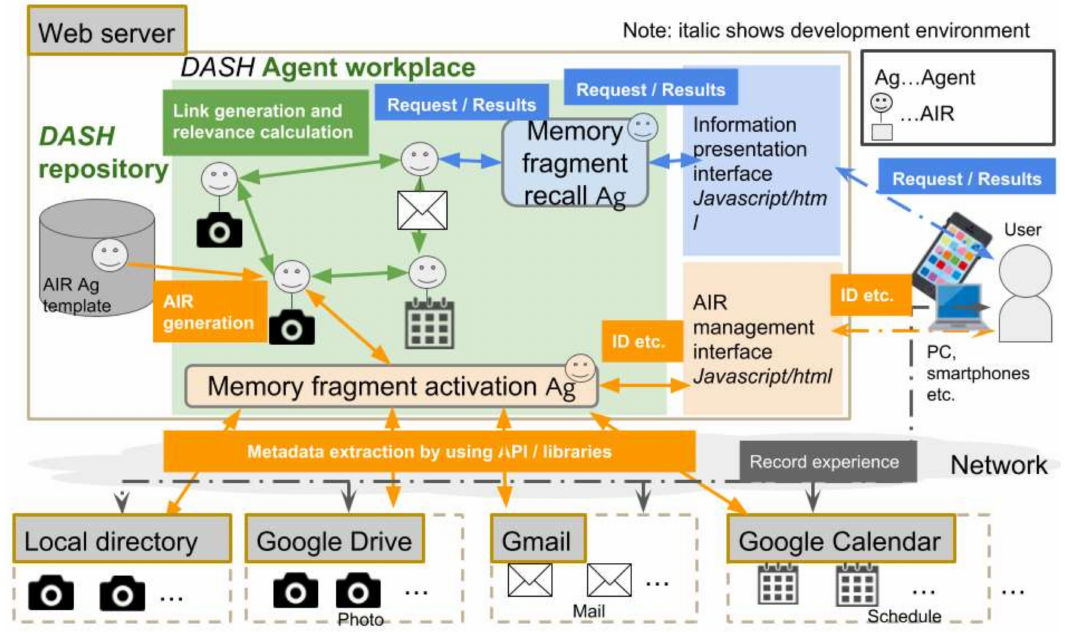
Figure 7. Implementation overview of the proposed memory recall support